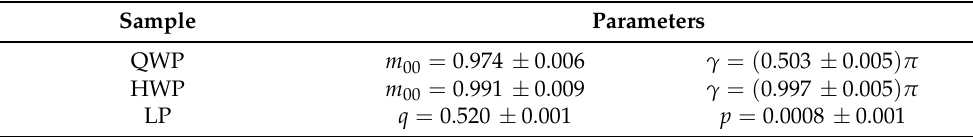
Table 1. Parameters of the samples. Transmittance ( m 00 ) and retardance ( γ ) for the wave plates and maximum ( q ) and minimum ( p ) transmittances for the linear polarizer. Sample Parameters